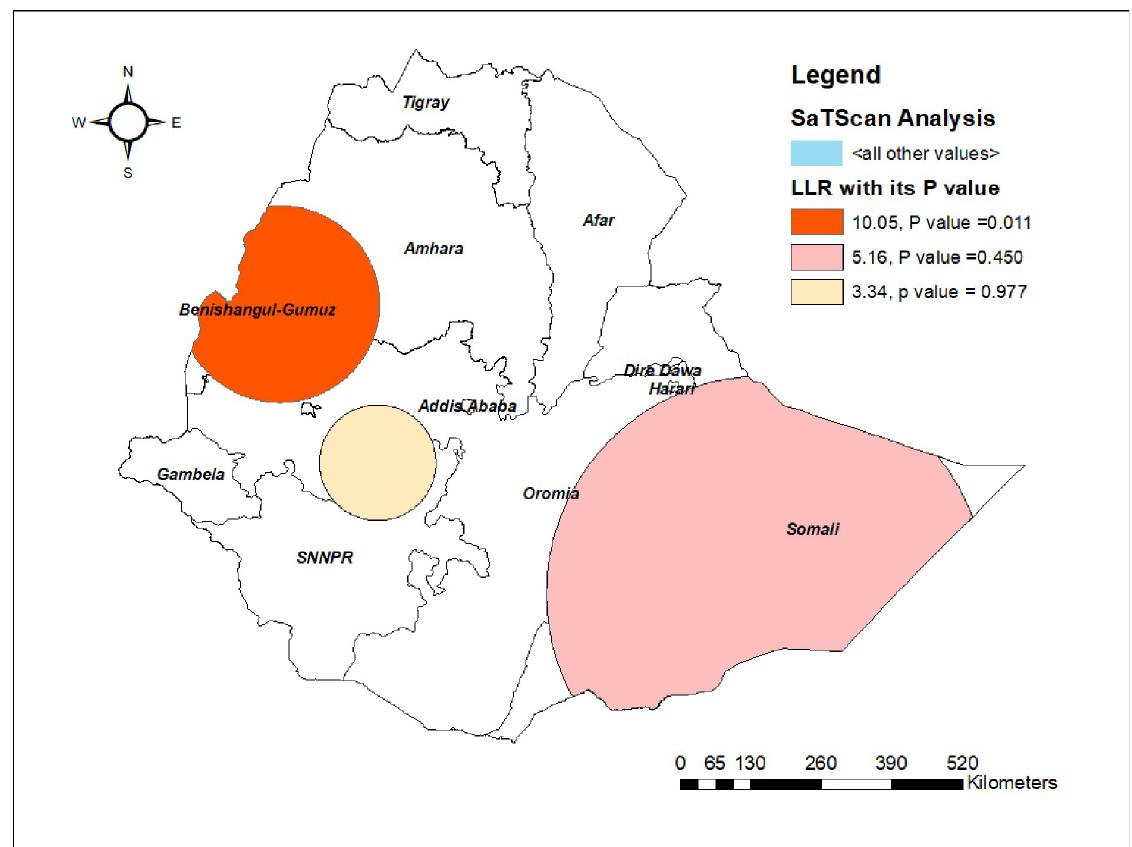
Fig 5. SaTScan analysis of non-uptake of MCV2 in Ethiopia, Map produced using Arc GIS version 10.7 and SaTScan version